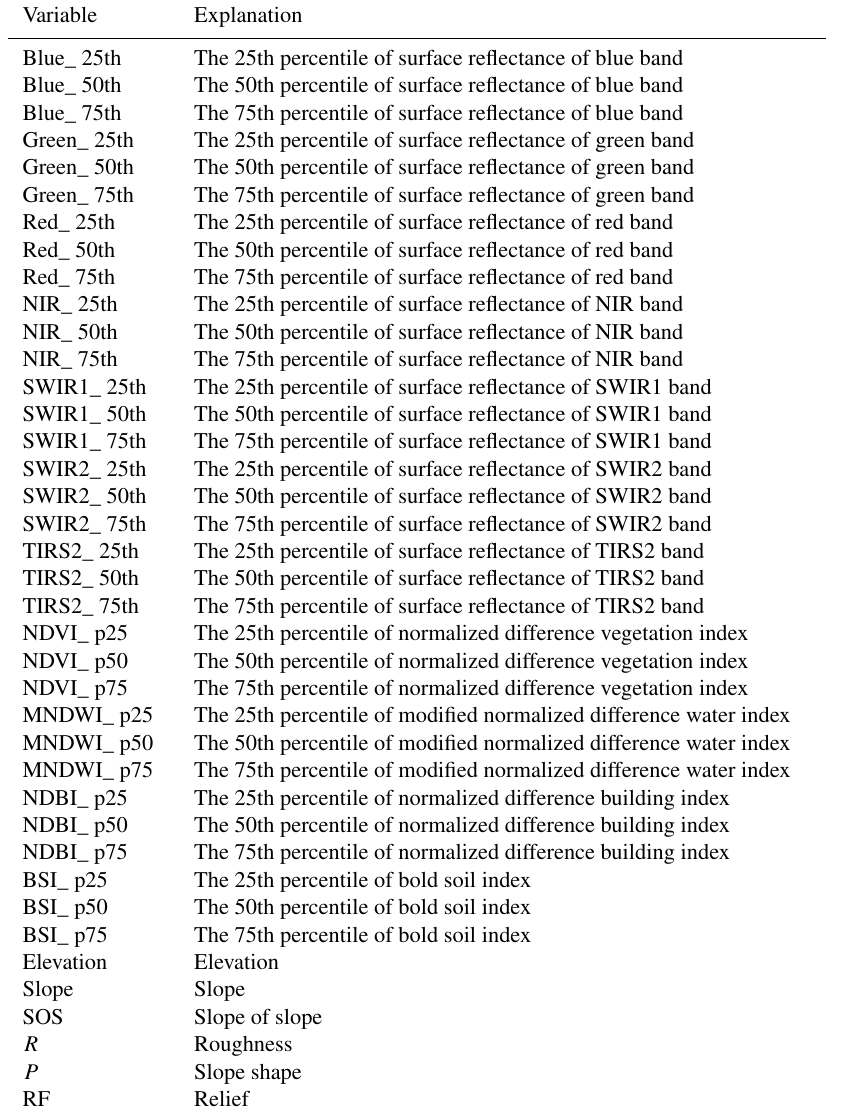
Table 5. Explanation of variables in Fig. 10 of Sect. 3.5.